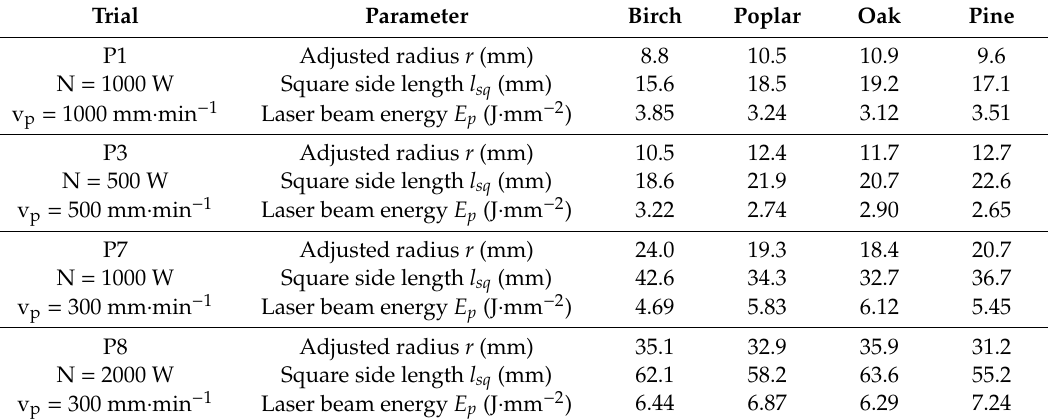
Table 2. Adjusted radii ( r ), equivalent square side lengths ( l sq ), and mean laser beam energies per 1 mm 2 of cut area ( E p ) for four tree species and four laser